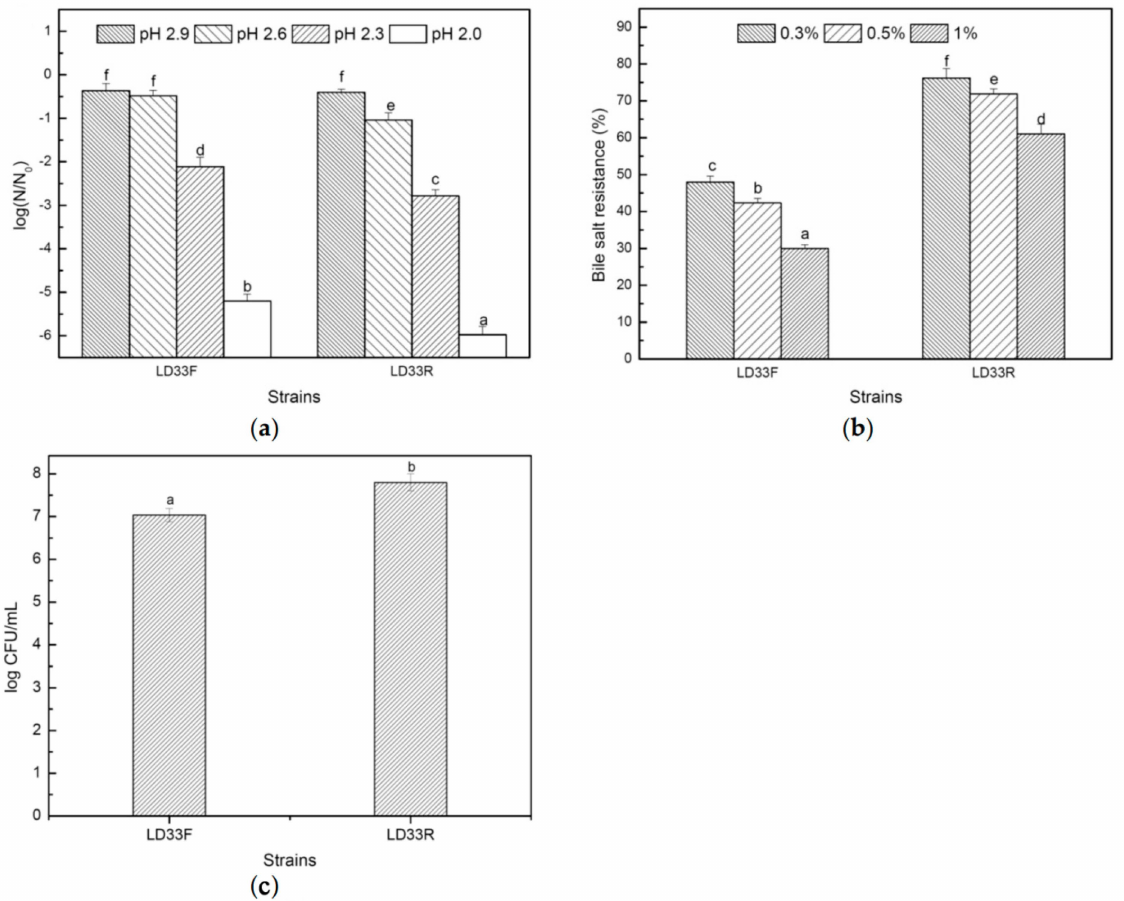
Figure 3. The probiotic effects of the strain E. faecalis LD33, including survival of E. faecalis LD33 ( a ) in an acid condition, ( b ) in bile salt condition, and ( c ) adhesion ability to colonic epithelium cells (HT-29 cells). LD33F and LD33R mean E. faecalis LD33 cultured under respiration-permissive and fermentation conditions, respectively. Different letters indicate significant differences ( p <